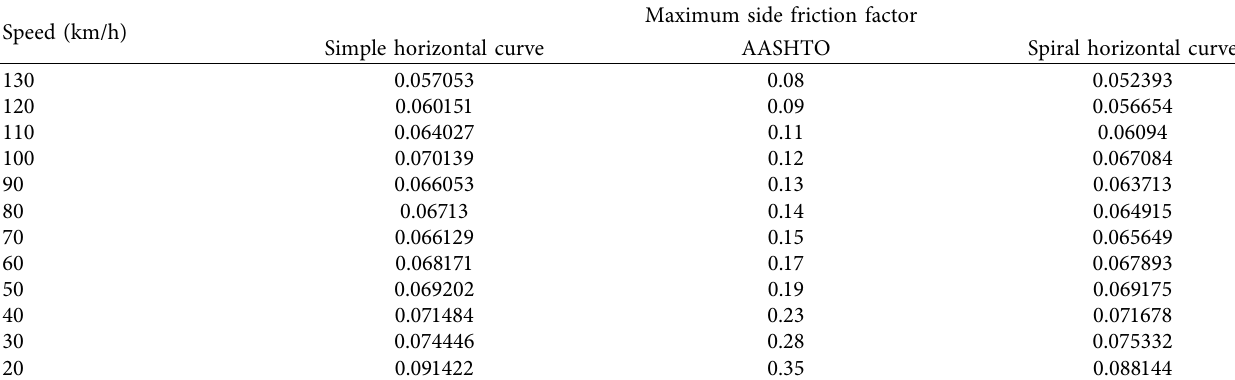
Table 9: Comparison of the maximum side friction factor for a truck between simple and spiral horizontal curves and AASHTO rec- ommended values at a radius of 1